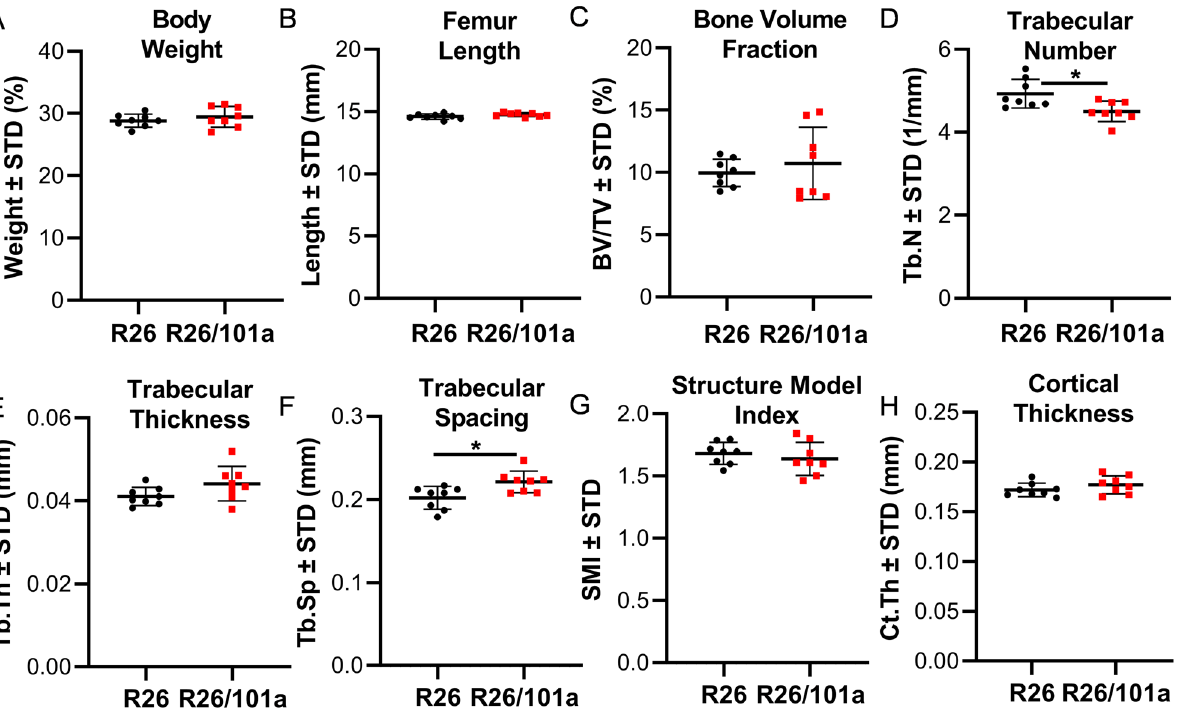
Figure 11. Post-weaning induction of miR-101a is insufficient to increase bone mass in male mice. R26 control and miR-101a over-expressing (R26/101) male mice were treated with doxycycline from 3 to 12 weeks of age. The figure depicts whole body weight ( A ) as well as femur length ( B ), trabecular bone parameters ( C–G ), and cortical thickness ( H ) as assessed by µCT (n = 8, mean ± STD). *p <